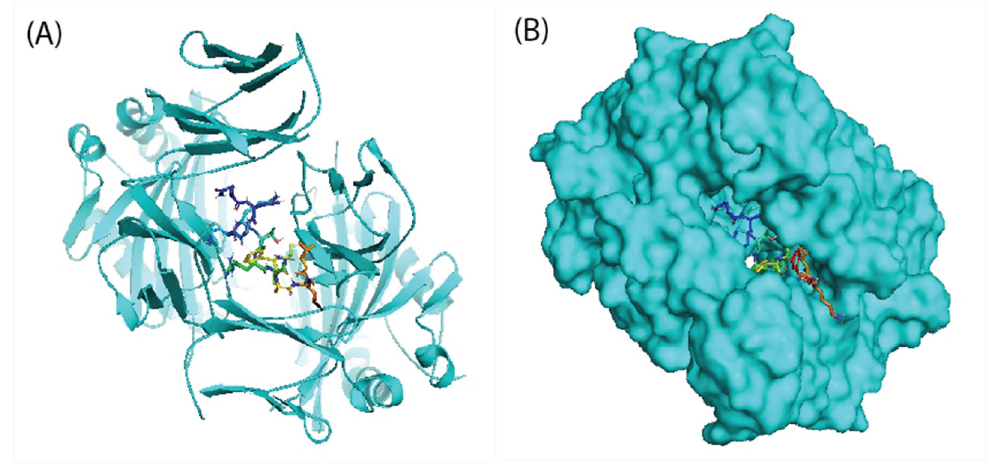
Figure 1. Docking visualization between the epitope QNGNKTRLAFAGLFK and its corresponding MHC allele (HLA-DRB1*15:01) using the software PyMol: ( A ) cartoon view; ( B ) surface view.